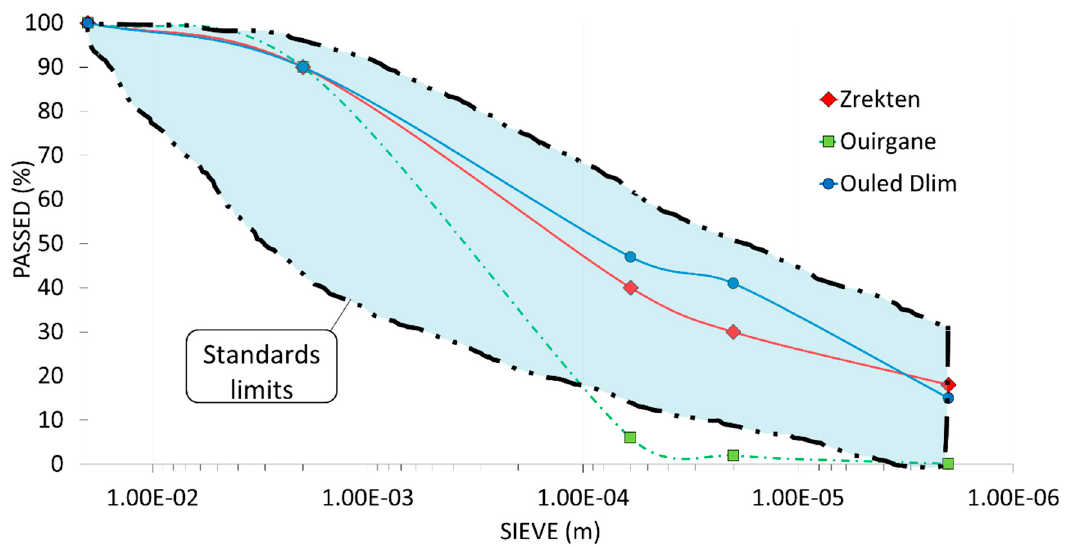
Figure 4. The standardization of particle size analysis [30,43]. Table 1. Proctor tests and Atterberg limits for the soils.